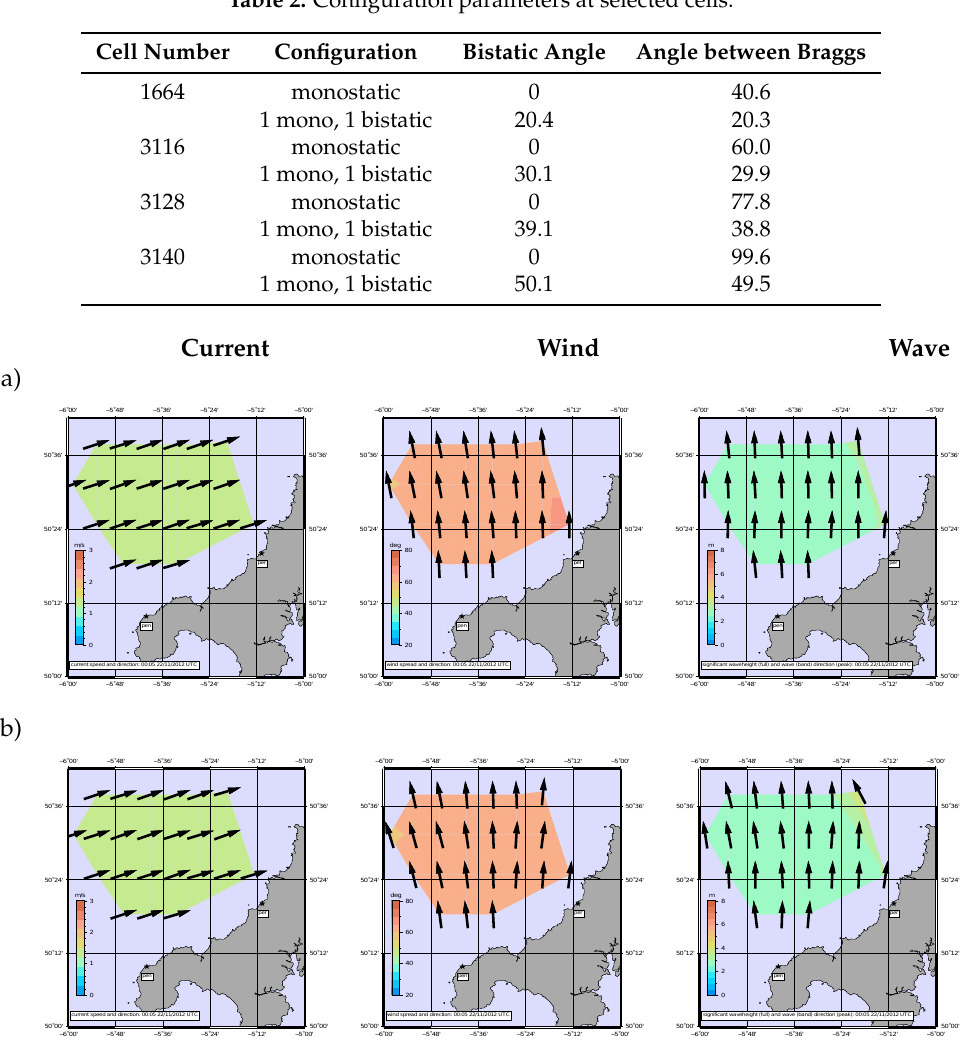
Figure 11. Inverted data for case 1. ( a ) monostatic ( b ) 1 bistatic. Current speed and direction on left, shortwave directional spreading and wind direction, centre, significant waveheight and peak direction,